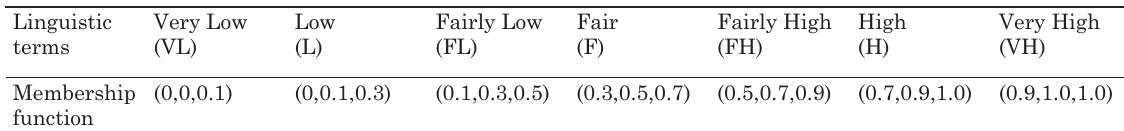
table 3. linguistic terms used for describing weighting values linguistic terms